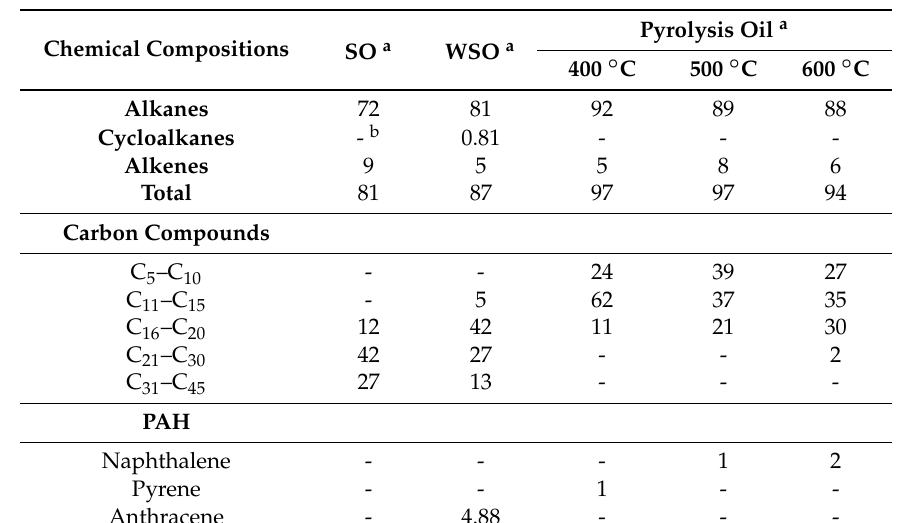
Table 1. Chemical compositions of original shipping oil (SO), waste shipping oil (WSO), and liquid pyrolysis oil obtained at different pyrolysis